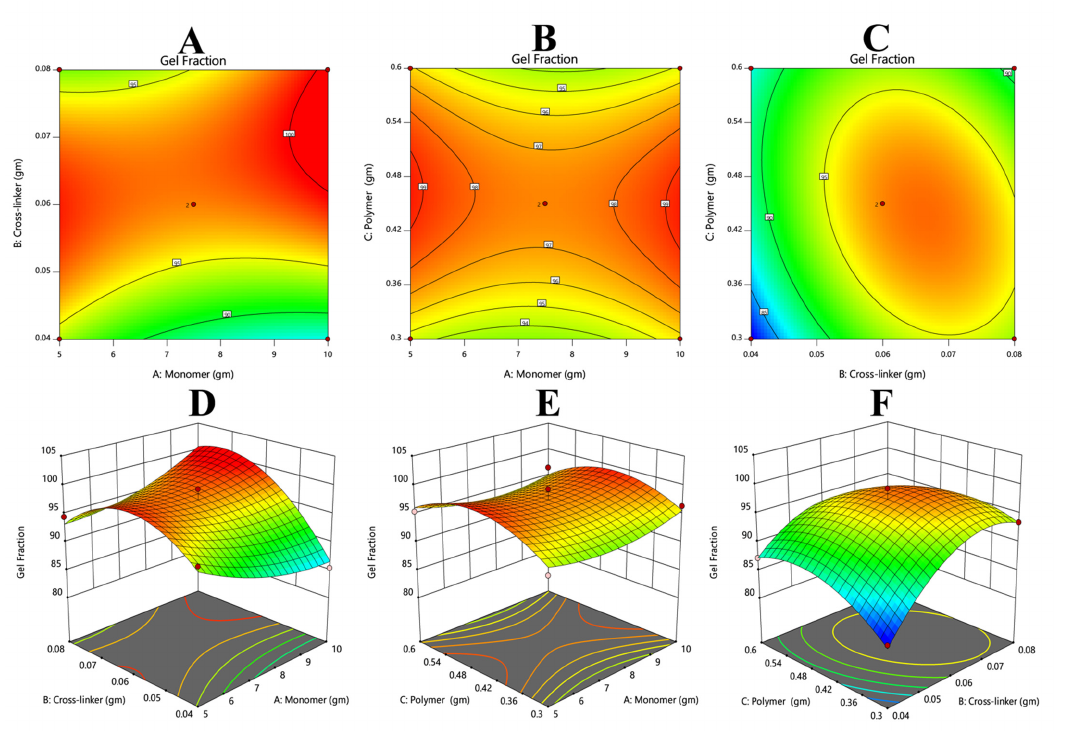
Figure 5. Describing the effects of varying the concentrations of crosslinker and monomer ( A , D ), polymer and monomer ( B , E ), and polymer and crosslinker ( C , F ). The pictorial representation de- scribes that increasing the concentration of crosslinker could be the cause of an increase in gel fraction and vice versa.